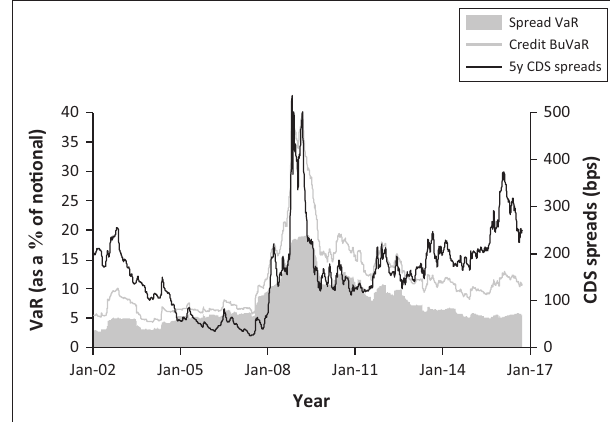
FIGURE 1: Credit risk measures on 5-year credit default swap spreads using standard deviation as a measure of volatility (risk-free rate = 7.00 % , bond recovery rate = 10 % , ω = 0.5). 2